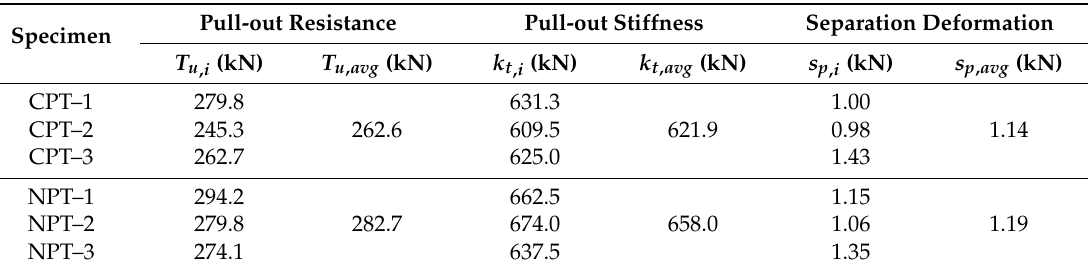
Table 2. Pull-out test results.